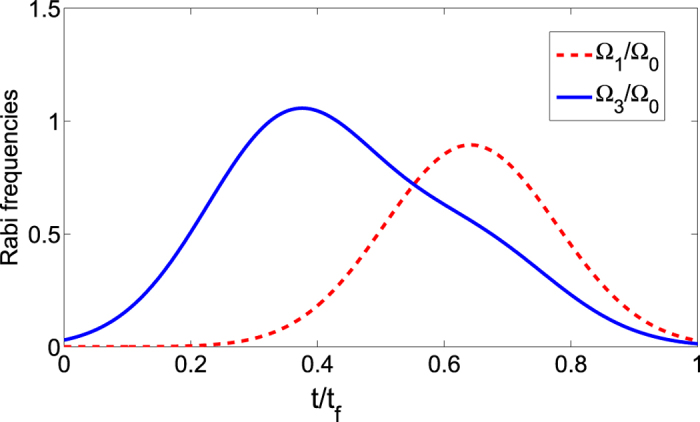
Dependence on t/tf of Ω1/Ω0 and Ω3/Ω0.